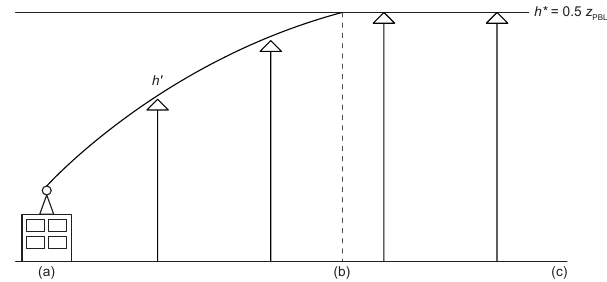
Figure 3. Growth of the effective mixing depth. From the recep- tor (a) , surface fluxes are diluted within an atmospheric column depth of h (cid:48) in the HNF until h (cid:48) = h ∗ (b) , amplifying the contri- bution of hyper near-field (HNF) sources and sinks to the receptor. Once h (cid:48) has reached h ∗ , surface fluxes are diluted to depth h ∗ until the end of the simulation (c)